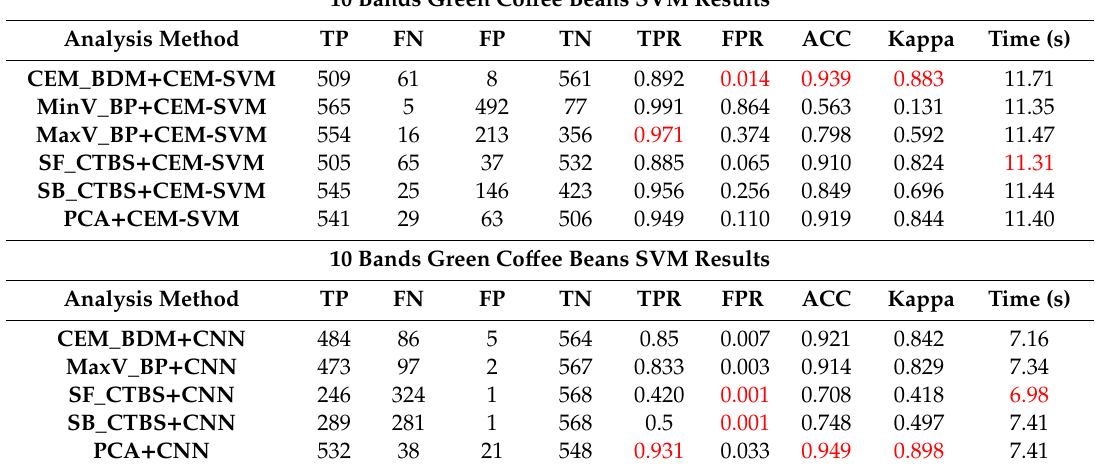
Table 5. The results of the green co ff ee bean classification. The best performance is highlighted in red color.